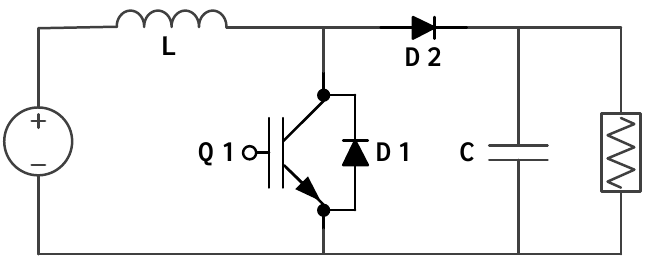
Figure 2. Circuit diagram of the conventional boost converter.